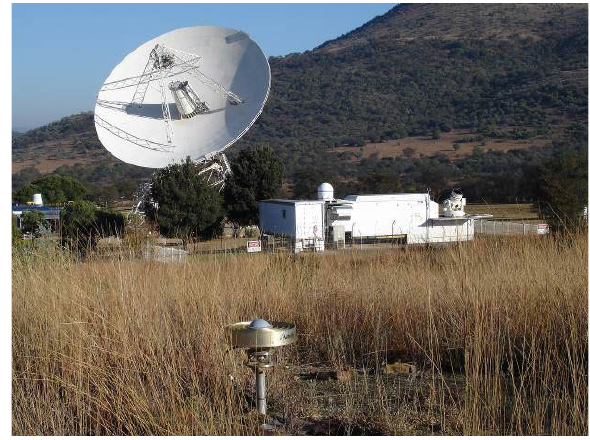
Source: Hartebeesthoek Radio Astronomy Observatory 37 . Figure 4: Geodetic techniques collocated at HartRAO: on the far left is the 26-m telescope for very long baseline interferometry and other astronomical observations; in the middle is the NASA MOBLAS-6 satellite laser ranging station; and in the foreground is the GPS